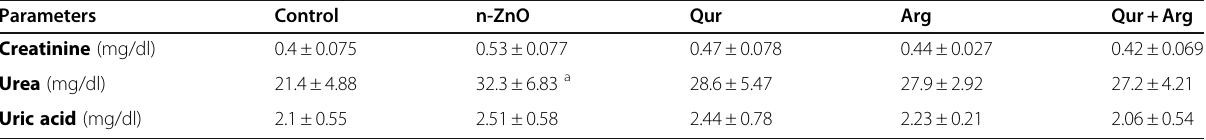
Table 3 Effect of Qur and/or Arg treatment on serum creatinine, urea, and uric acid levels in intoxicated rats with a low dose of n-ZnO particles Parameters